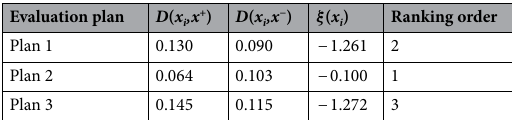
Table 9. Closeness coefficients of design concept plans.